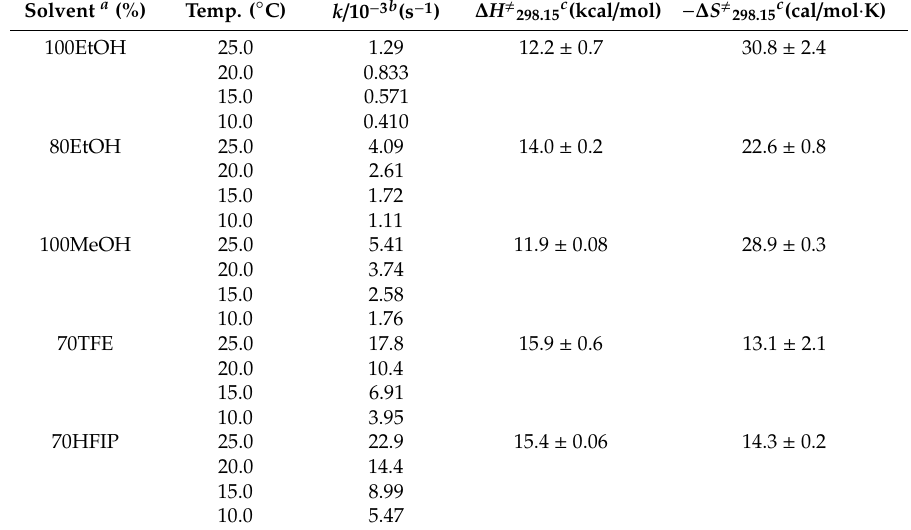
Table 3. Rate constants ( k ) and activation parameters ( ∆ H (cid:44) and ∆ S (cid:44) ) for the solvolysis of 2 in aqueous binary mixtures at various